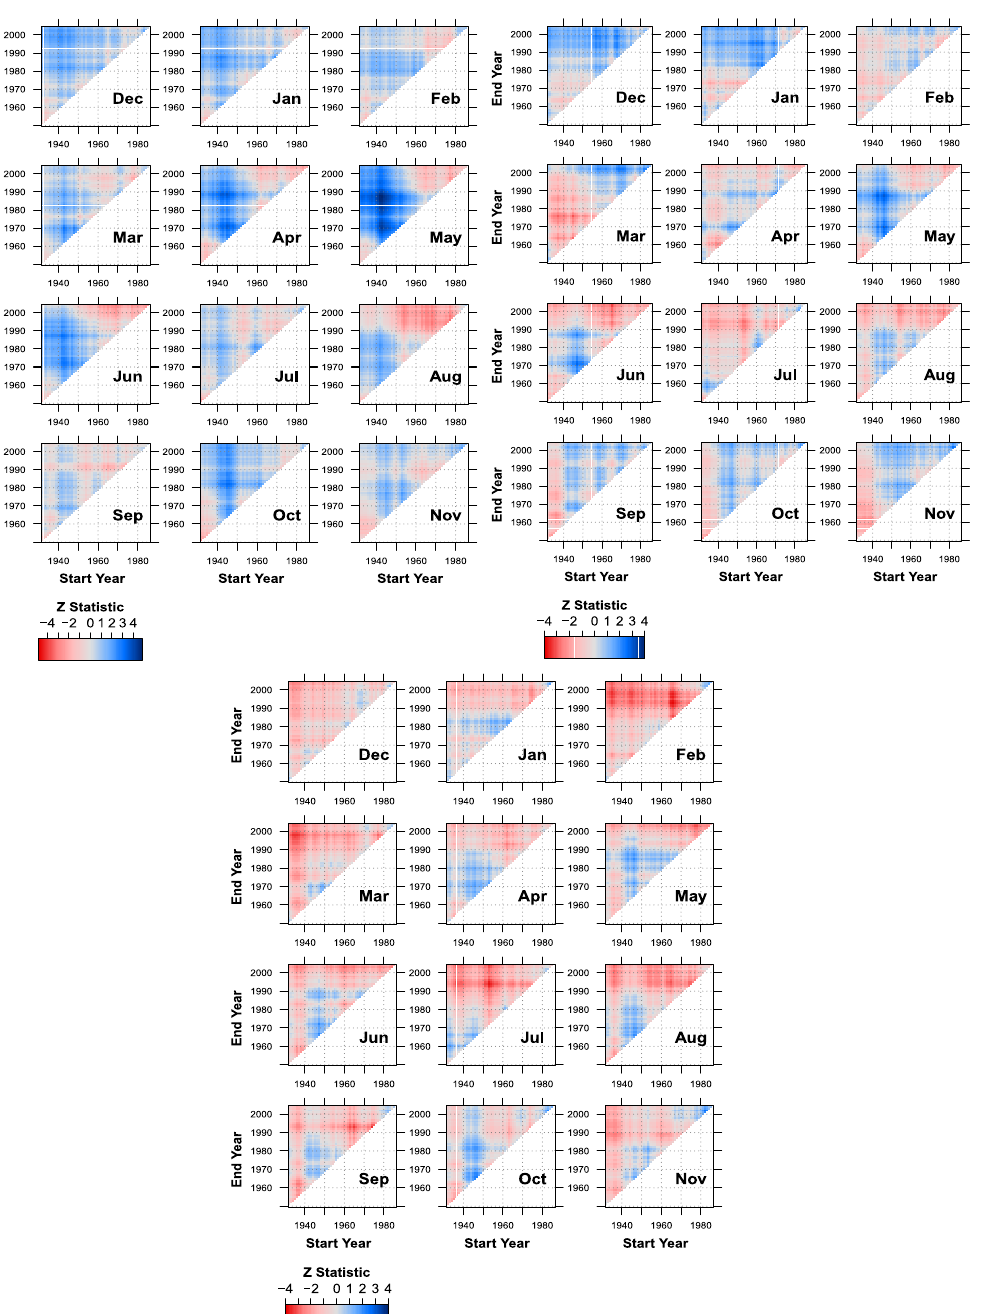
Fig. 7. Multi-temporal trend analysis for individual months for (upper left) Central West, (upper right) Central and (bottom) Central East regions. Explanation as for Fig.